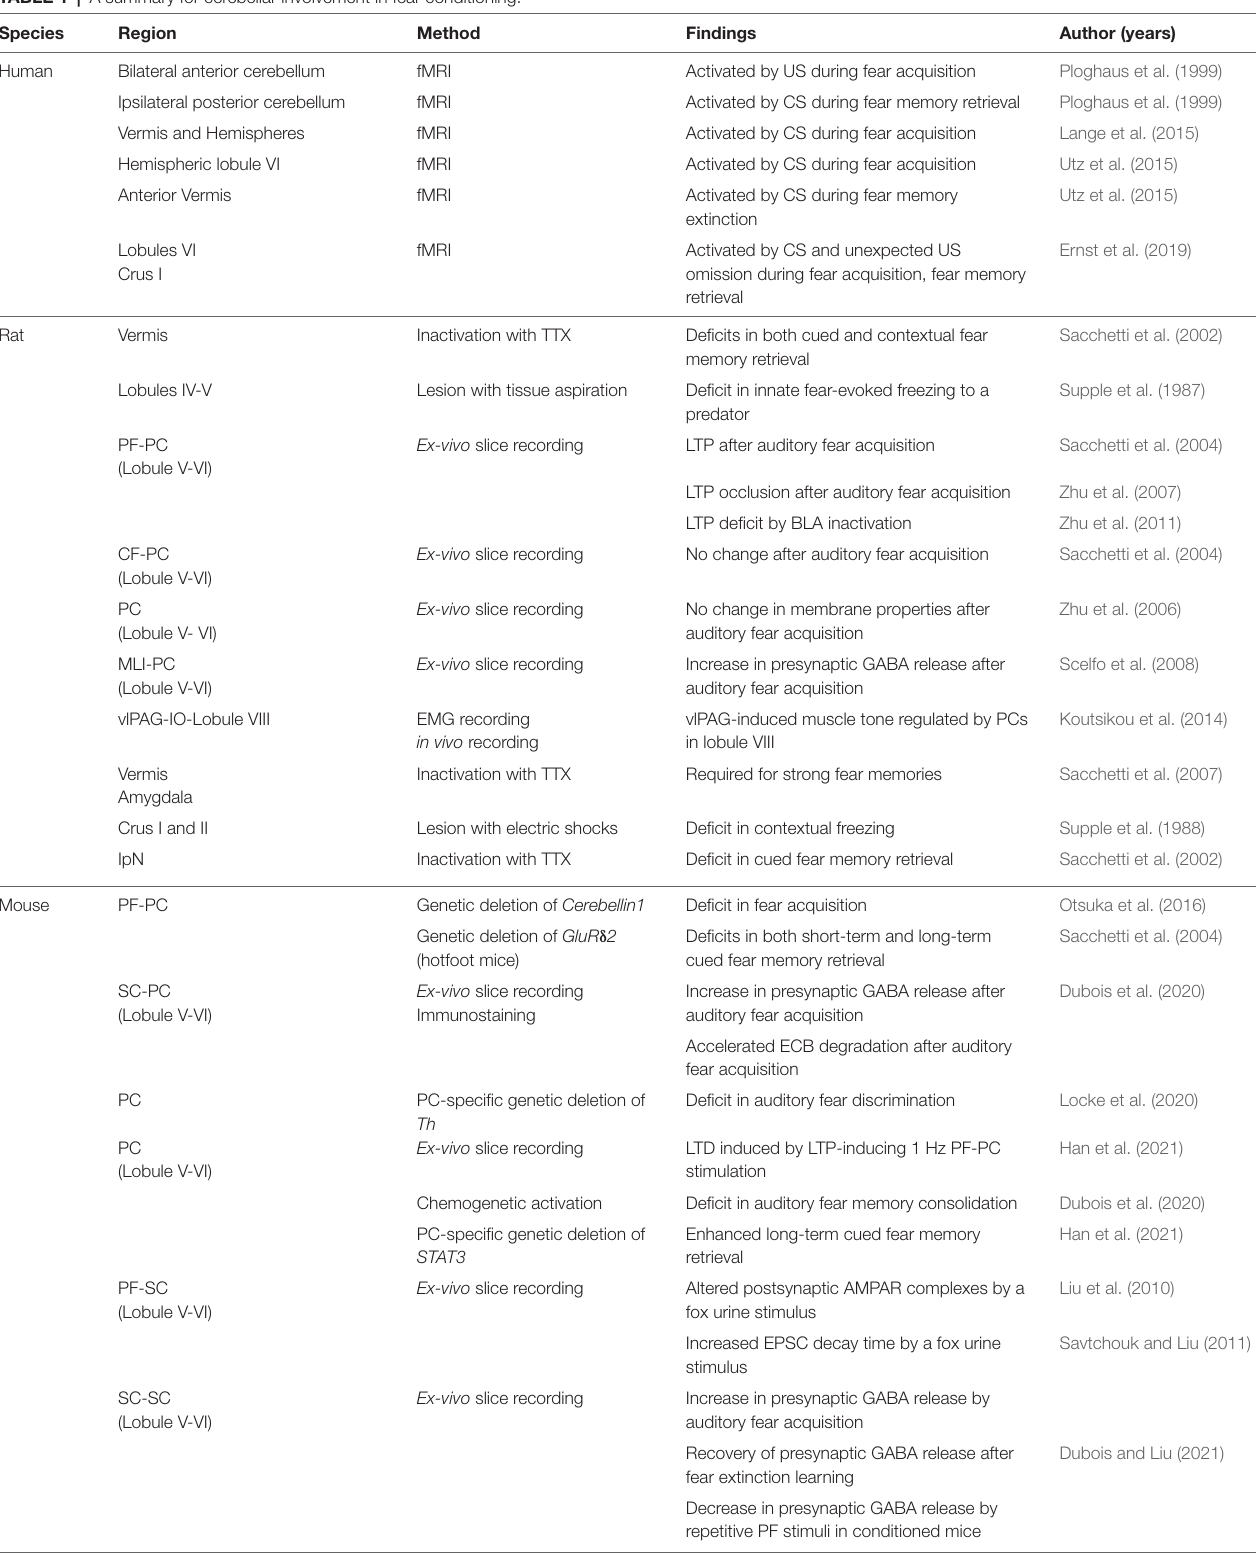
TABLE 1 | A summary for cerebellar involvement in fear